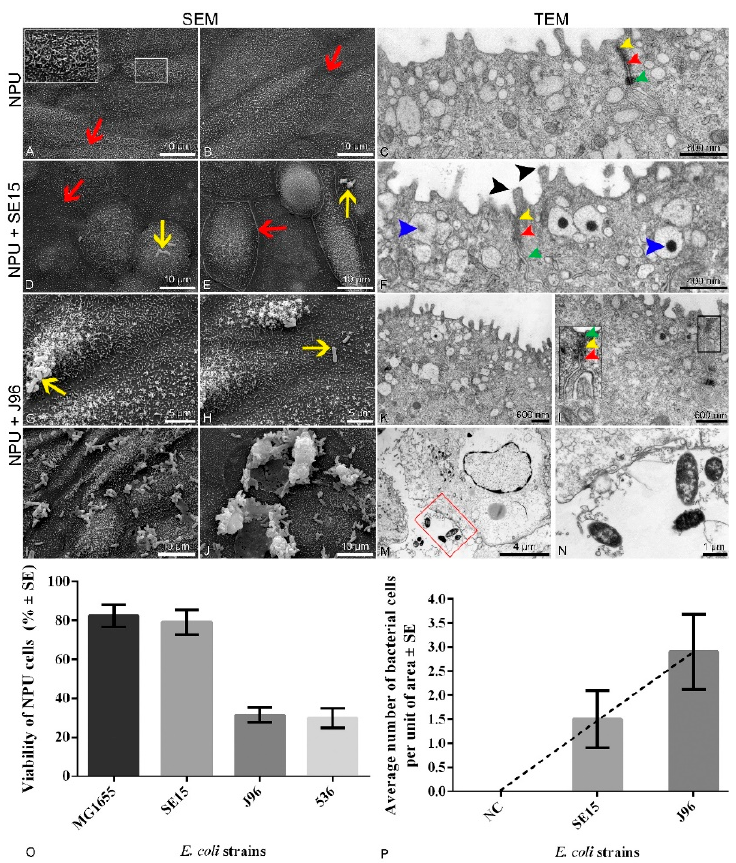
Figure 1. Apical plasma membrane surface topography of the normal porcine urothelial (NPU) cells of biomimetic urothelial in vitro model, captured by scanning electron microscope (SEM), and the micrographs of the cellular ultrastructure of the model captured using transmission electron microscope (TEM). In vitro model ( A – C ) incubated without bacteria (negative control). Borders of adjacent urothelial cells (( A , B ), red arrows) are seen, as well as a network of intertwined surface microvilli (( A ), white line inset). Tight junctions are normally developed (( C , F , L ), yellow arrowheads) as well as adherent junctions (( C , F , L ), red arrowheads) and desmosomes (( C , F , L ), green arrowheads). Overview of the surface of the in vitro model infected with human commensal SE15 E. coli strain ( D , E ) shows the presence of rare bacterial cells per unit of the NPU cell apical surface (yellow arrows). There were no detected bacterial cells in the cytoplasm of NPU cells infected with SE15 ( F ). Glycocalyx can be seen on the surface of the microvilli (( F ), black arrowheads), as well as dark aggregates discoidal or fusiform-shaped vesicles (DFVs) (( F ), blue arrowheads). The SEM micrographs of the apical surface of the in vitro model infected with the human uropathogenic J96 E. coli strain show the presence of attached individual (( G , H ), yellow arrows) or groups of bacteria ( I , J ) in a much higher number per unit of the apical area compared to the models infected with SE15. ( K ) In rare cases the morphology of urothelial cells incubated with J96 has been preserved. Cell junctions were preserved in only a few regions (( L ), black line inset) and were disrupted in most cases, as is seen in ( M ). J96 disrupted the normal morphology of the urothelium, and J96 bacteria were present also in the extracellular matrix ( M , N ). Image ( N ) is an enlarged red square marked in figure ( M ). Insets framed with white or black are 200% enlarged, corresponding to smaller white or black insets. Two independent experiments were performed to examine the effect of different bacterial strains on ultrastructural characteristics of NPU cells. The representative micrographs are shown. ( O ) Percentage of viable NPU cells following infection with a set of control non-pathogenic (MG1655 and SE15) strains and pathogenic (J96 and 536) E. coli strains. Results were obtained from four biological samples in altogether at least 10 independent experiments. Error bars represent standard error of the mean (SE). ( P ) Number of individual bacterial cells attached to the apical cell surface of the in vitro